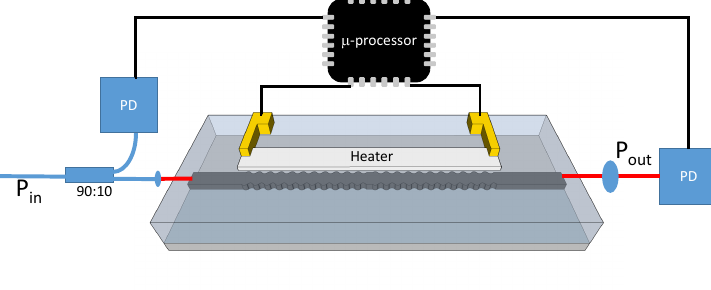
Figure 5. Schematic of the feedback control scheme for the micro-resonator device. The micro-processor stores the transfer matrix method (TMM) model of the device and calculates an error signal based on the measured transmitted power and injection power, taking the on-resonance position as a working point.